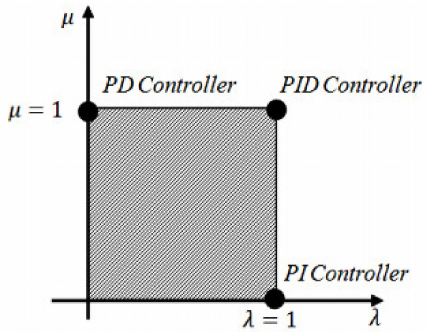
Figure 2. Interpretation for FO-PID and IO-PID control